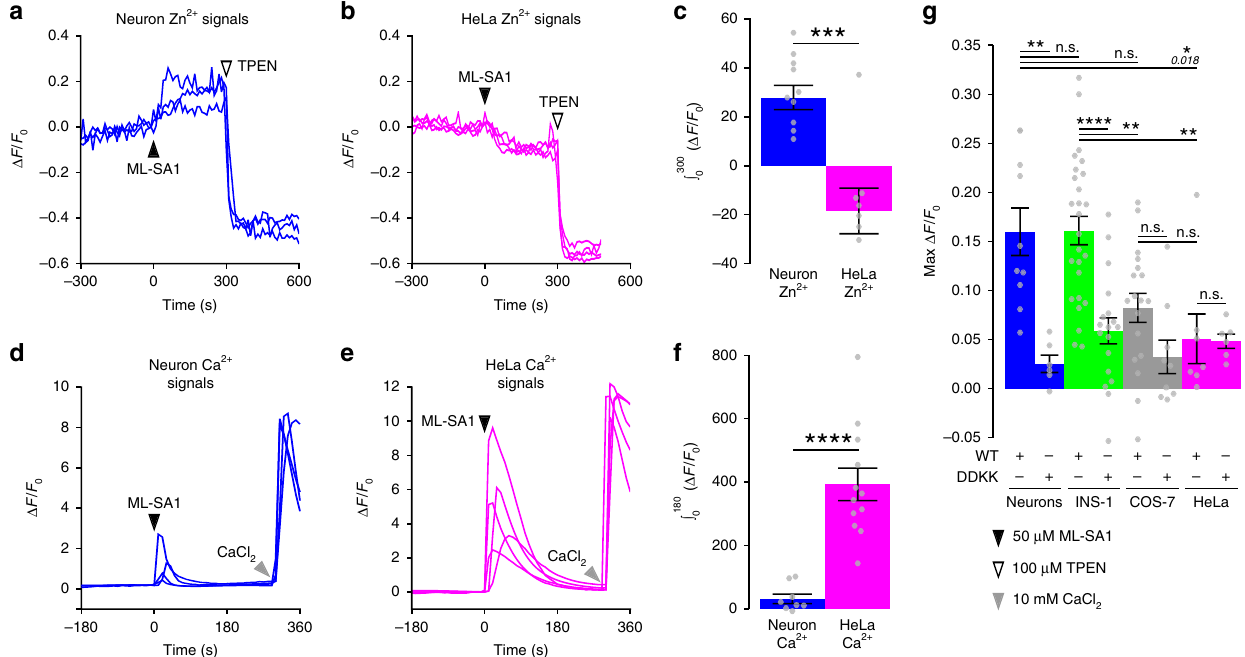
Fig. 7 TRPML1-mediated Zn 2 + signals are higher in neurons and INS-1 cells than other mammalian cell types. a Representative traces of primary rat hippocampal neurons co-expressing GZnP3 and mCherry-TRPML1. Neurons were treated with 50 µ M ML-SA1 at 0 s (black arrow) and 100 µ M TPEN at 300 s (white arrow). b Representative traces of HeLa cells co-expressing GZnP3 and mCherry-TRPML1. Cells were treated as described in a . c Mean integrated GZnP3 signal (±s.e.m.) 300 s after ML-SA1 addition for both neurons (blue, n = 10 cells) and HeLa cells (magenta, n = 7). Two-tailed Student ’ s t -test. d Representative traces of primary rat hippocampal neurons co-expressing GCaMP5 and mCherry-TRPML1. Neurons were treated with 50 µ M ML- SA1 at 0 s (black arrow) and 10 mM CaCl 2 at 300 s (gray arrow). e Representative traces of HeLa cells co-expressing GCaMP5 and mCherry-TRPML1. Cells were treated as described in d . f Mean integrated GCaMP5 signal (±s.e.m.) 180 s after ML-SA1 addition for both neurons (blue, n = 8) and HeLa cells (magenta, n = 12). Two-tailed Student ’ s t -test. g Mean GZnP3 signal maximum (±s.e.m.) 300 s after ML-SA1 addition for both TRPML1 WT and TRPML1 DDKK in neurons (blue; WT, n = 10; DDKK, n = 7), INS-1 cells (green; WT, n = 26; DDKK, n = 18), COS-7 cells (gray; WT, n = 18; DDKK, n = 9), and HeLa cells (magenta; WT, n = 7; DDKK, n = 6). One-way ANOVA with post-hoc Tukey HSD. **** p < 0.0001, *** p < 0.001, ** p < 0.01, * p < 0.05, n.s. not signi fi cant. p -values listed in italics above corresponding comparisons where applicable. Source data are provided as a Source Data fi